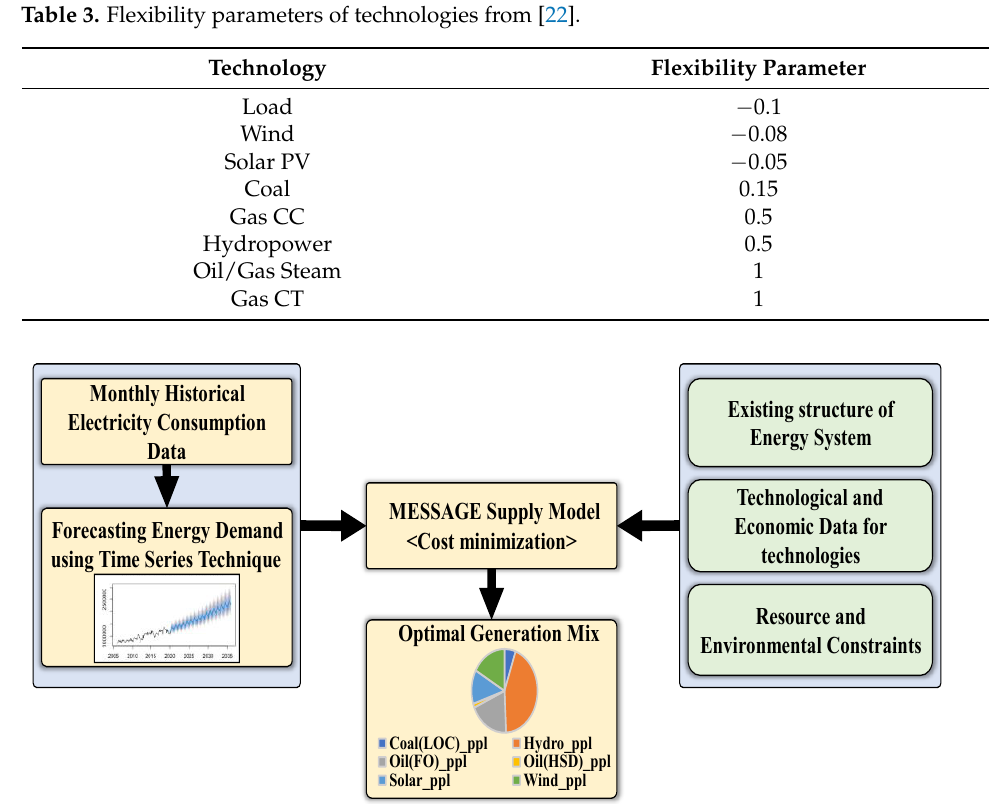
Figure 6. Integration of demand-supply